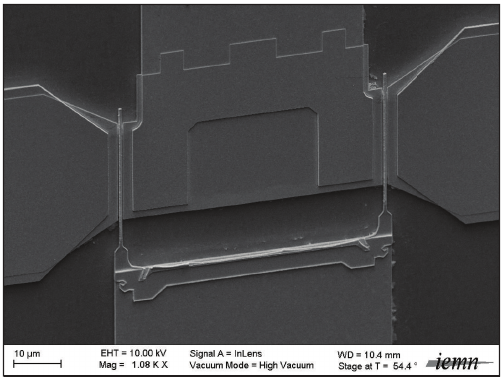
Figure 2: 100nm AlSb/InAs HEMT.